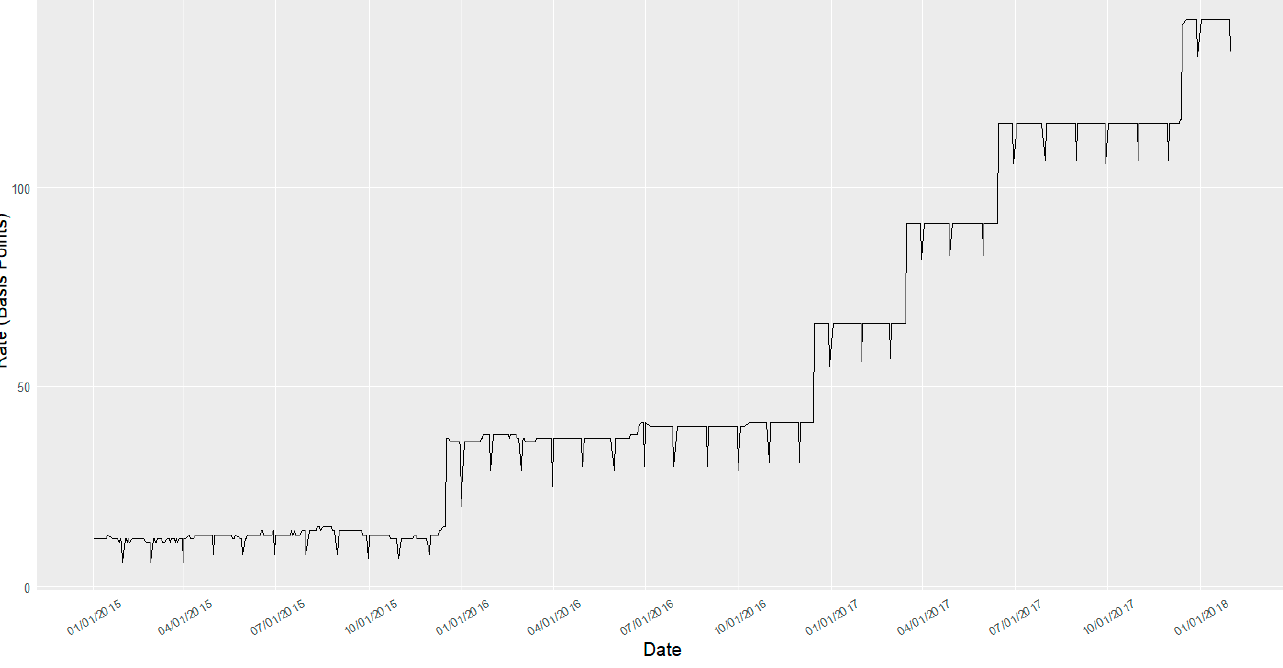
Figure 4. Time Series Plots of Effective Federal Funds Rate (January 2015 through January 2018). This month-end rate drop pattern is unusual for the money market instruments. The only other identified month-end effect in money markets that we are aware of is by Park and Reinganum (1986) in T-bills and it is not isolated on the last trading day of the month. They observe that last T-bill to mature in a month trades at a yield lower than the sur- rounding T-bills. T-bills are discount instruments so lower yields come from higher prices. Ogden (1987) suggests that the pattern is consistent with a preferred habitat from the in- vestors buying specific (month-end) T-bills. Such a case cannot be made for our month-